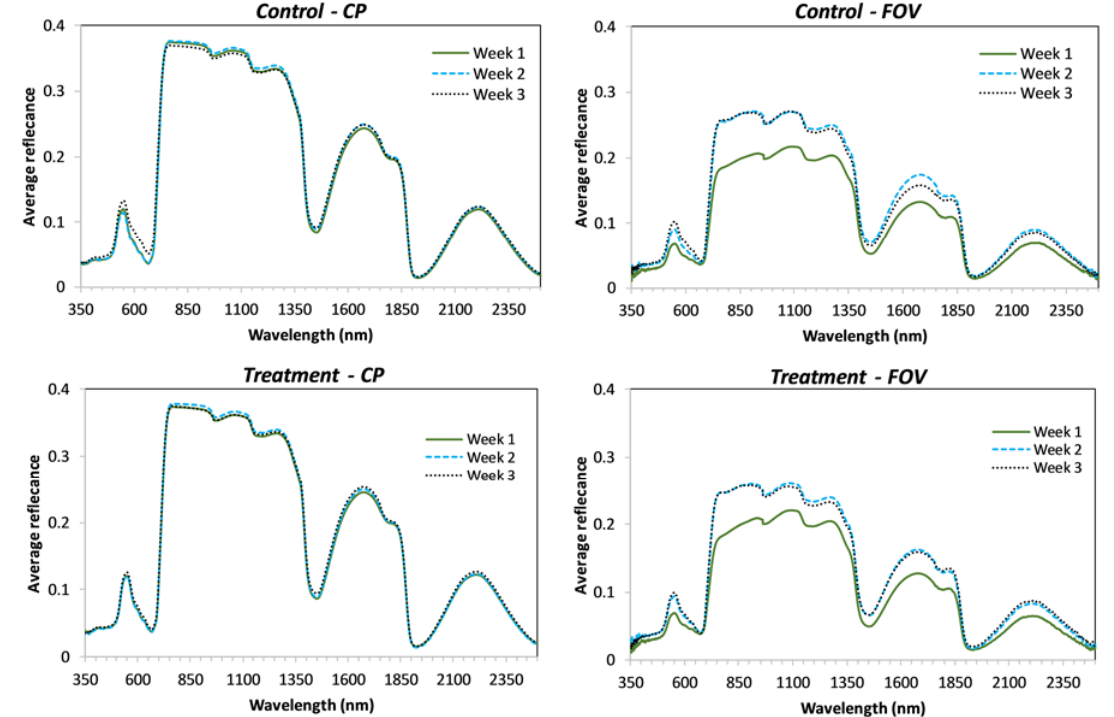
Figure A2. Control and treatment spectra for Z. mays as acquired by CP and FOV.